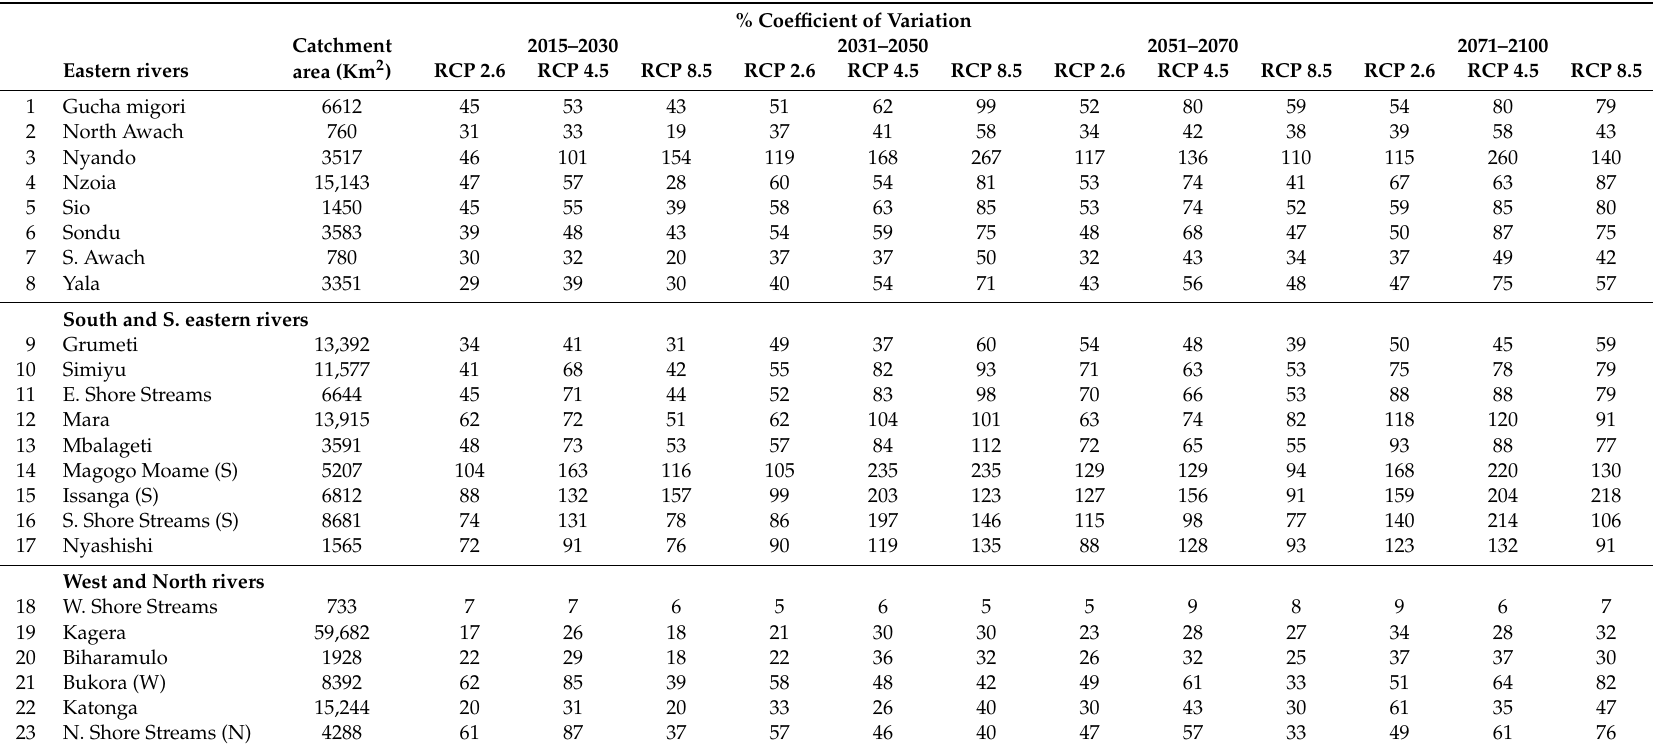
Table 1. Estimated coe ffi cient of variation of discharge for rivers flowing into Lake Victoria for